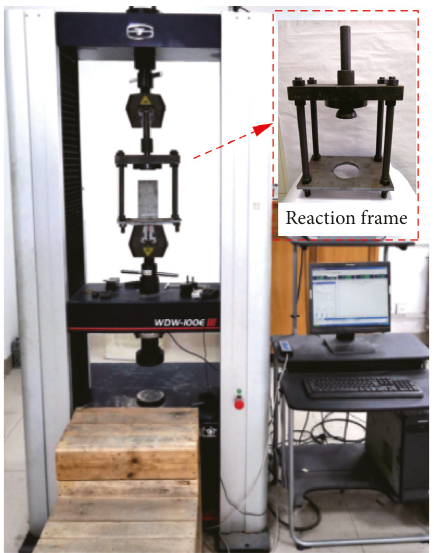
Figure 5: Experimental device of central pull-out